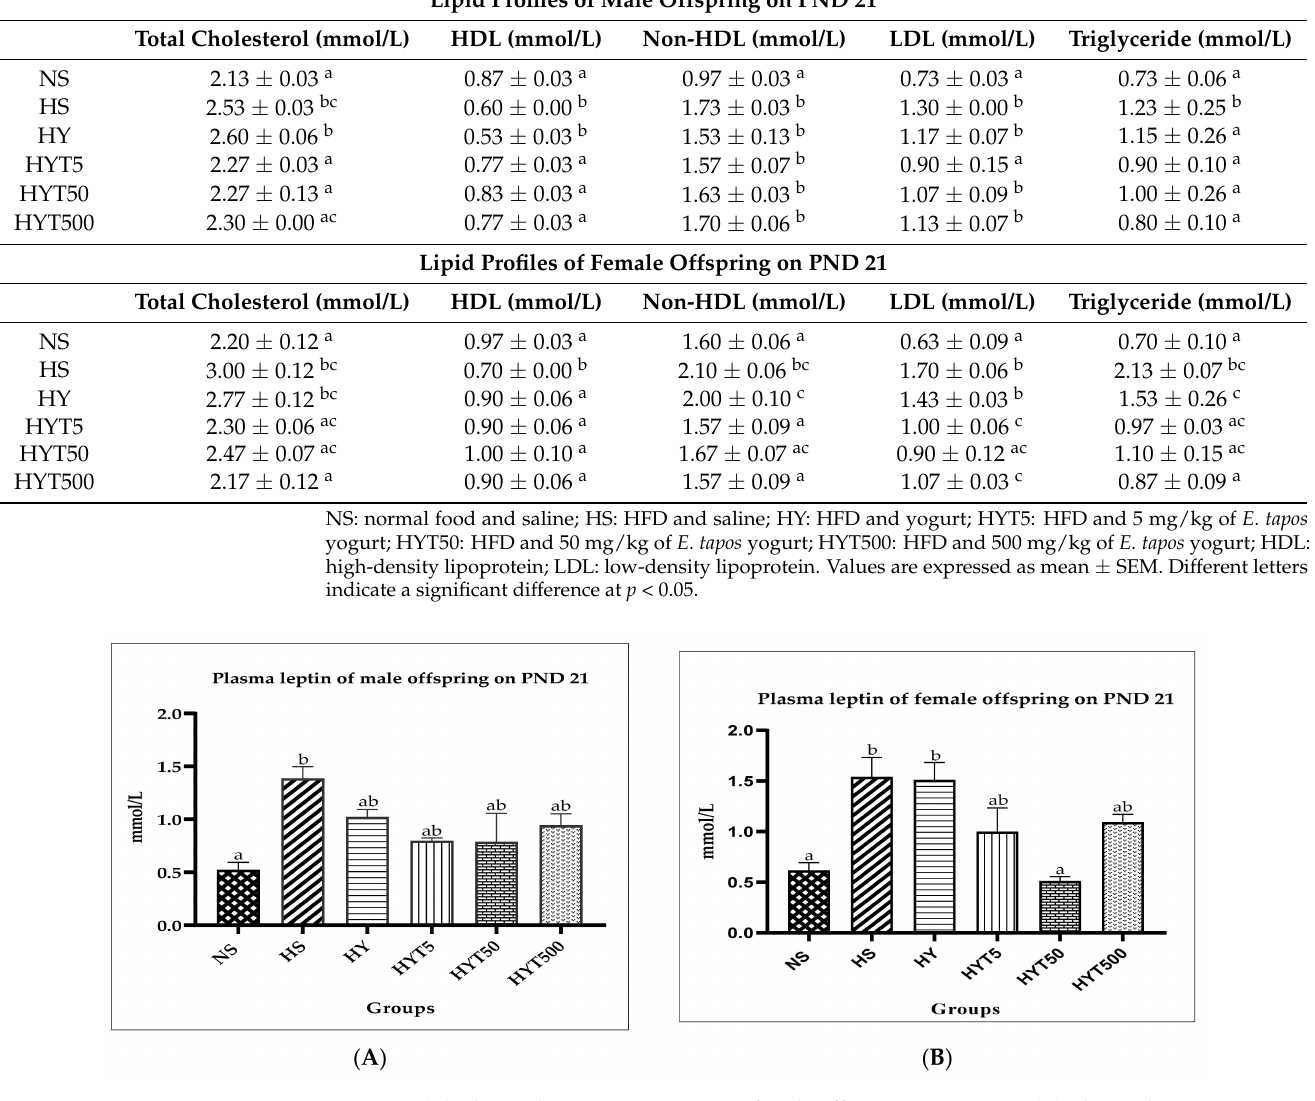
Table 4. Lipid profiles of male and female offspring on PND 21. Lipid Profiles of Male Offspring on PND 21